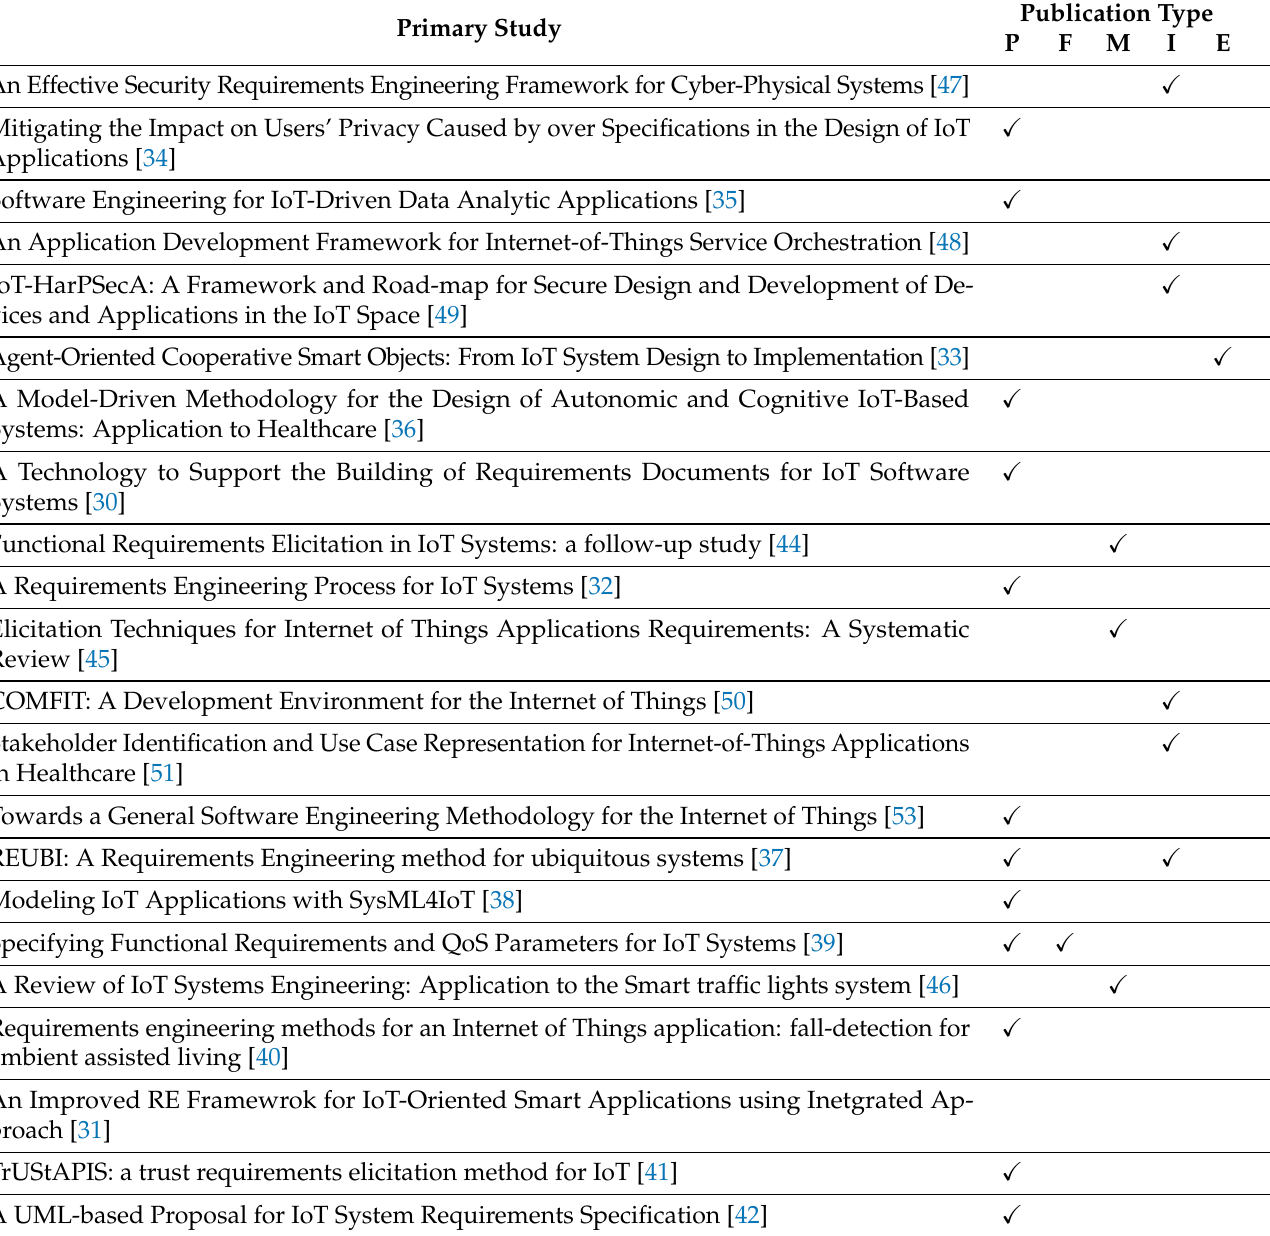
Table 5. Classification scheme per primary study